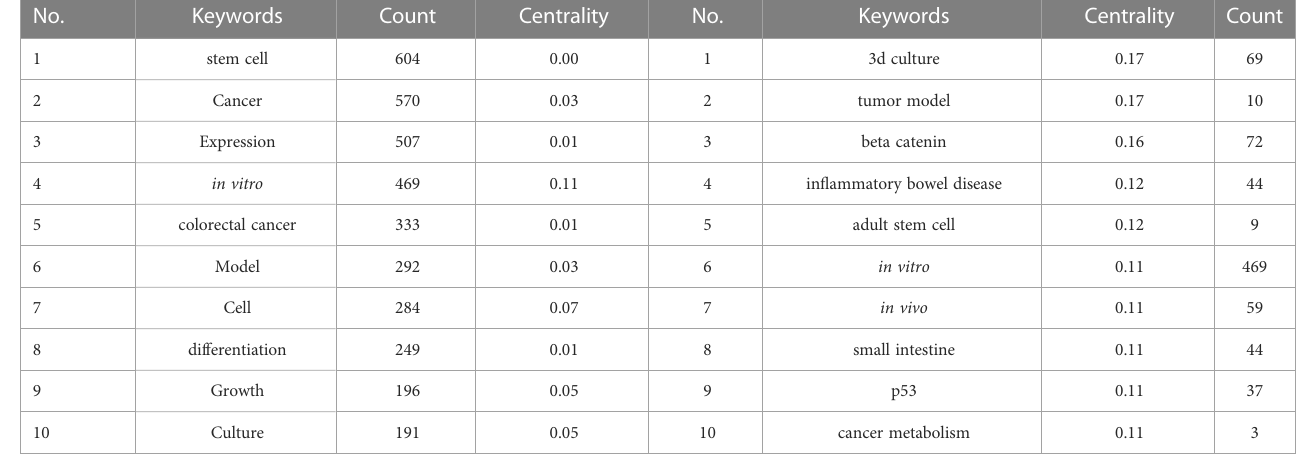
TABLE 7 The top twenty most frequently occurring keywords and their centrality in research related to tumor organoids. No.